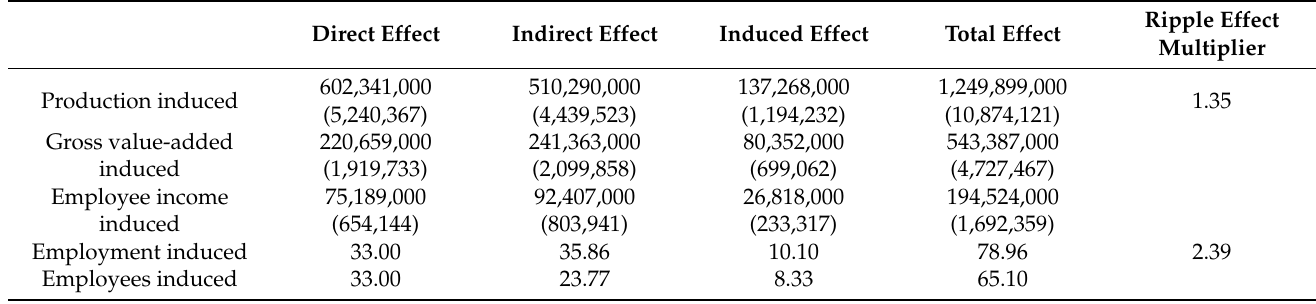
Table 3. Economic ripple effects of the GLT sector (unit: JPY (USD),